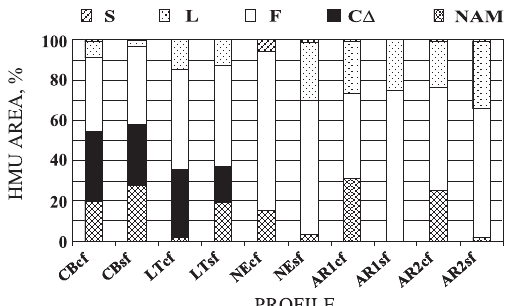
Figure 2. Percentage of homogeneous morphological units (HMUs) in the 0–20 cm layer of the profiles of soil treated with green manure (S: area adjusted by the software to offset profile surface irregularities; L: loose; F: cracked, C ΔΔΔΔΔ : continuously compact; NAM: unaffected by cultivation; soil: Cambissolo (CB) (Inceptisol), Latossolo (LT) (Oxisol), Neossolo (NE) (Entisol), Argissolo (AR1 and AR2) (Alfisol); cf: maize intercropped with jack bean, sf: sole